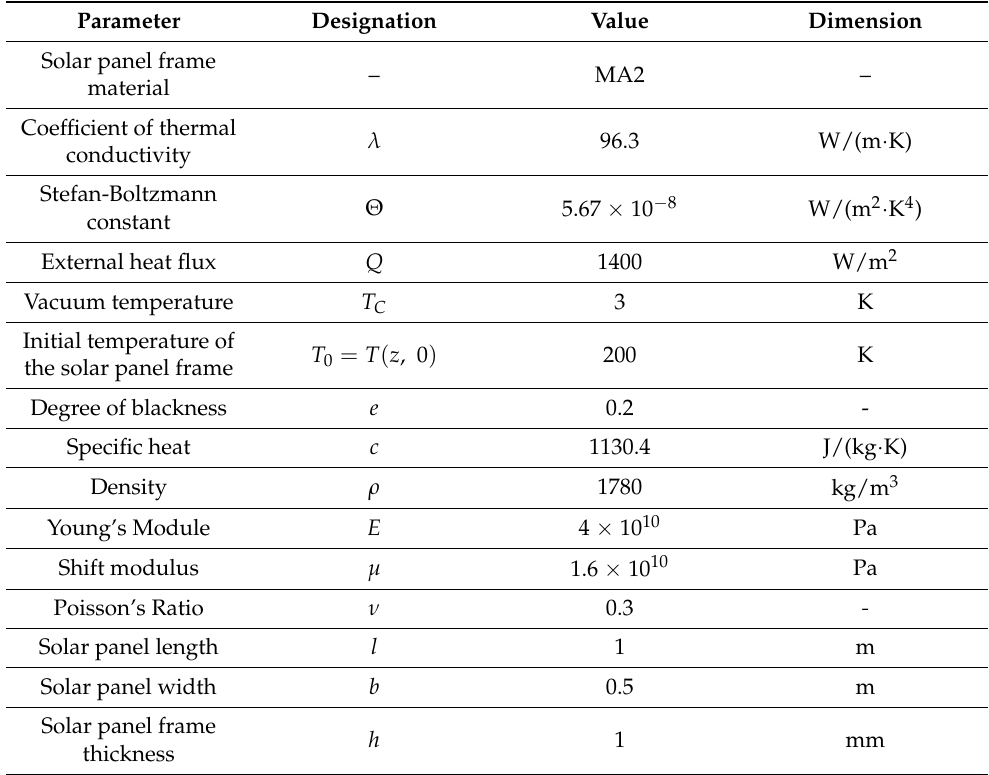
Table 1. The main parameters of the simulated